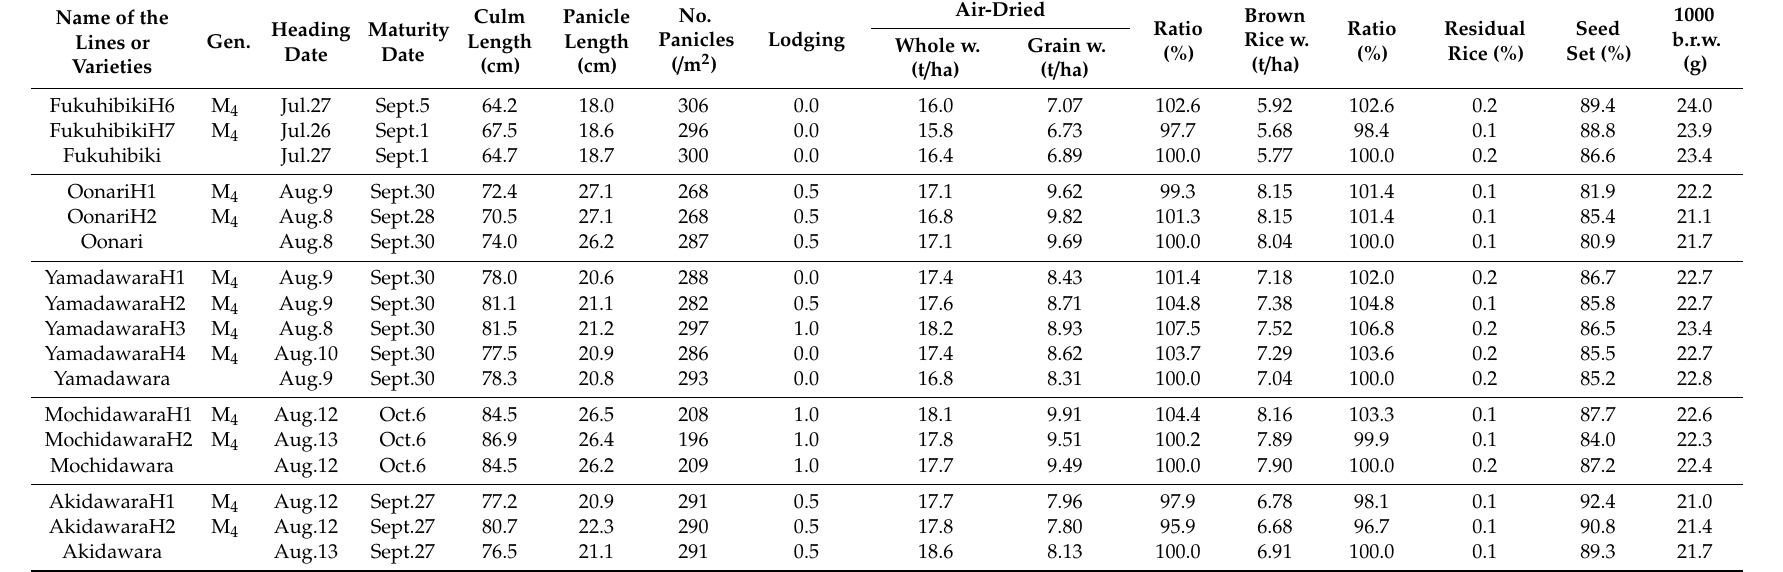
Table 1. Yield trial of mutants in paddy field with standard fertilizer application in Ibaraki, Japan in